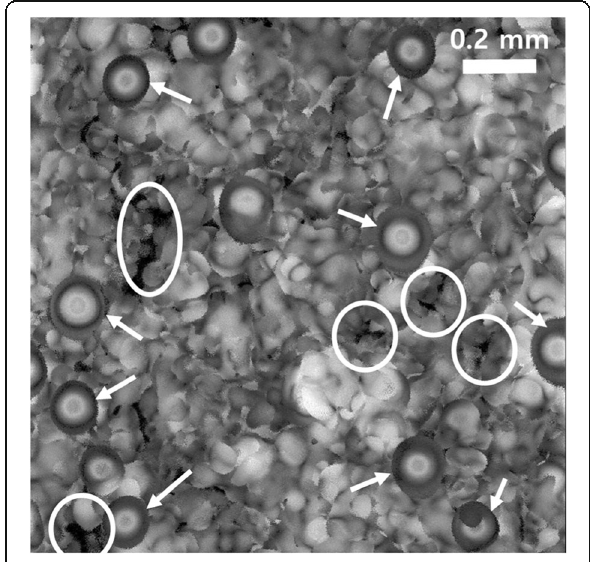
Fig. 8 A lateral scan parallel to the scalp surface showing the microvessels (open circles) and hair follicles (arrows) (110 MHz transducer, lateral resolution ~ 15 μ m, 1024 px × 1024